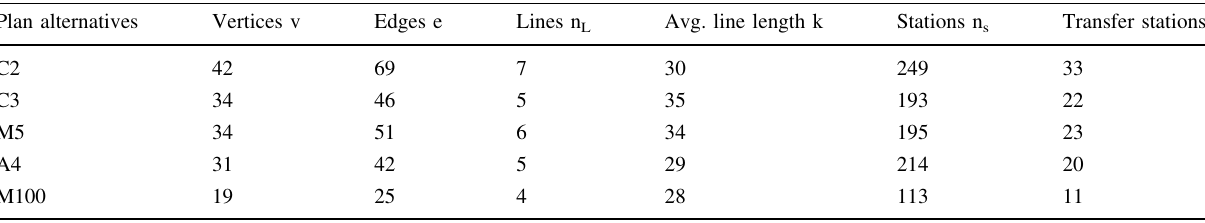
Table 4 Tel Aviv plan alternatives—network data Plan